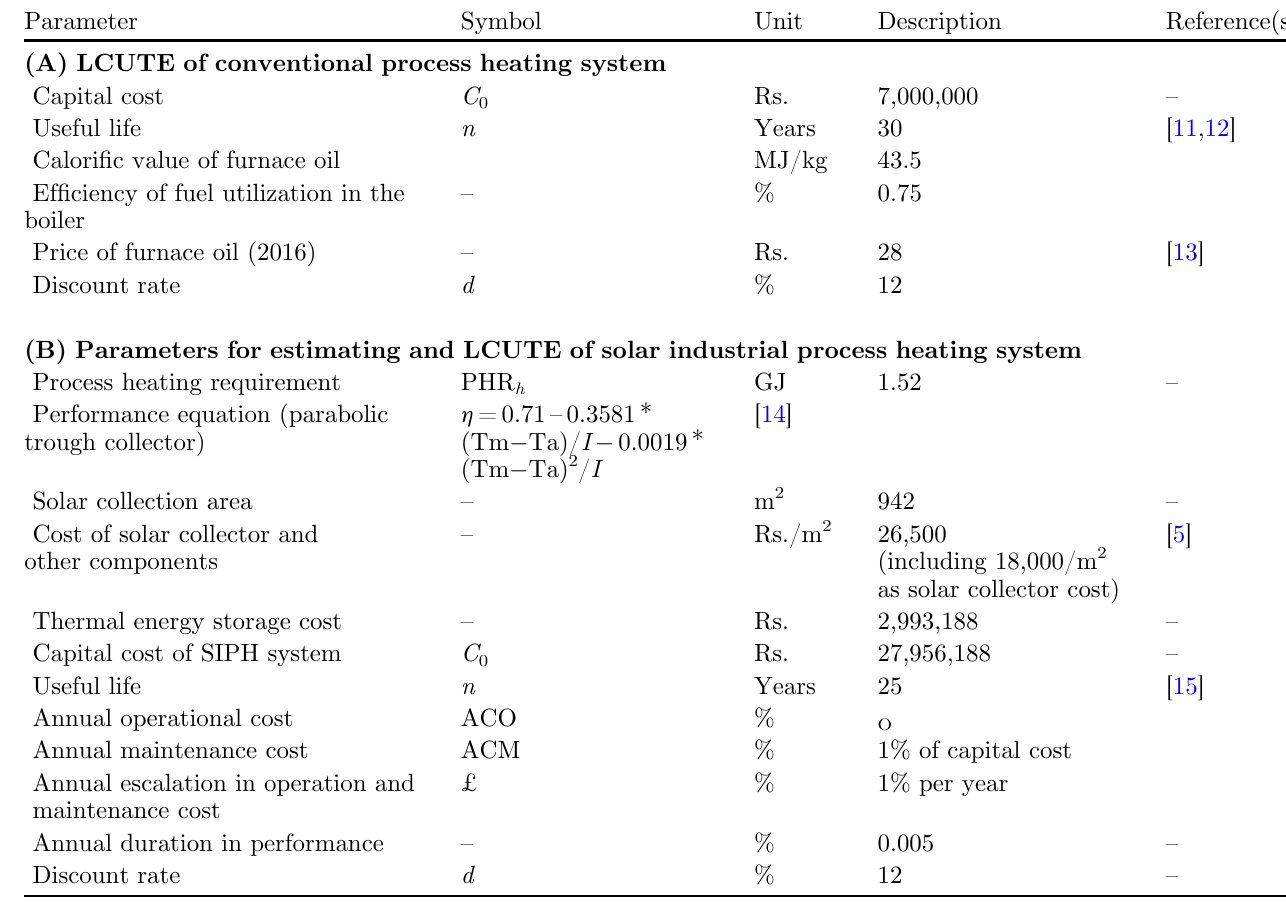
Table 1. Input parameters used for estimating the annual useful thermal energy delivered and corresponding LCUTE for SIPH system and LCUTE for conventional process heating